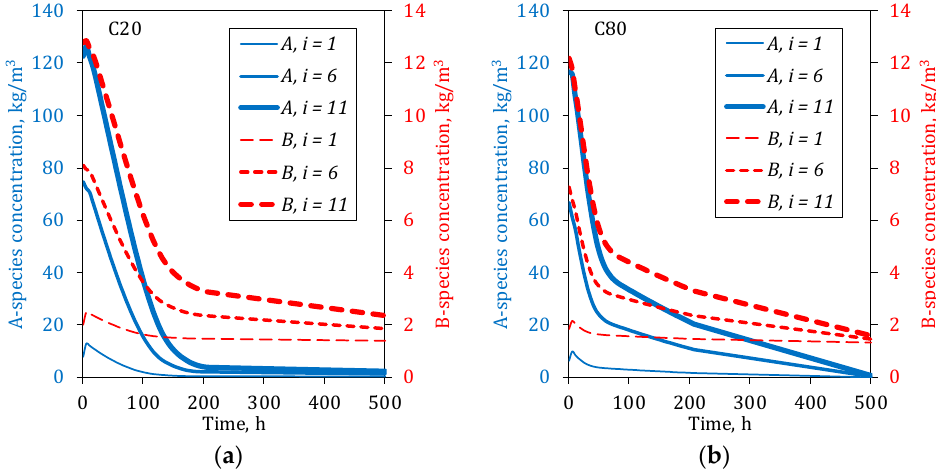
Figure 7. Simulated concentrations as a function of time at three different depths into the column for both species with different granulometry ( a ) C20 column and ( b ) C80 column. Solid lines describe A-species and dashed lines B-species. Wider lines indicate deeper reactors and i = 11 denotes the last reactor and the outlet concentration from column.